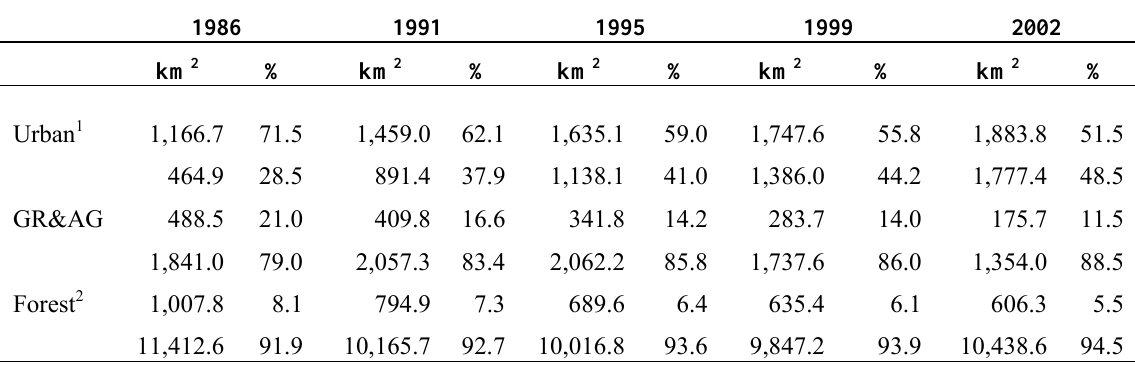
Table 5. Land cover area (km 2 ) and percent (%) of class over time inside (In) and outside (Out) of the 2002 Urban Growth Boundaries